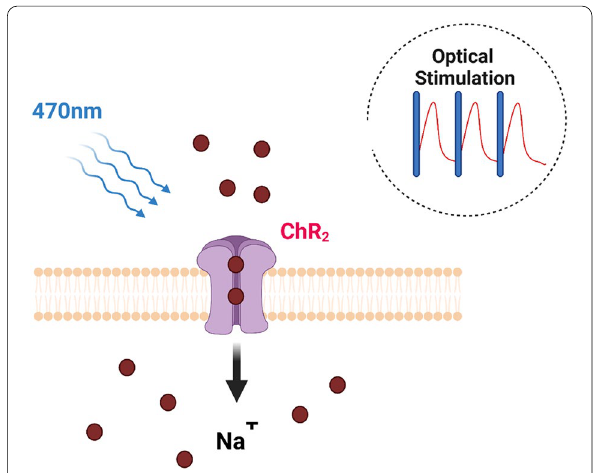
Fig. 4 Light‑gated ion channel modulation by optogenetic stimulation and burst action potential. Figure created with BioRender. com